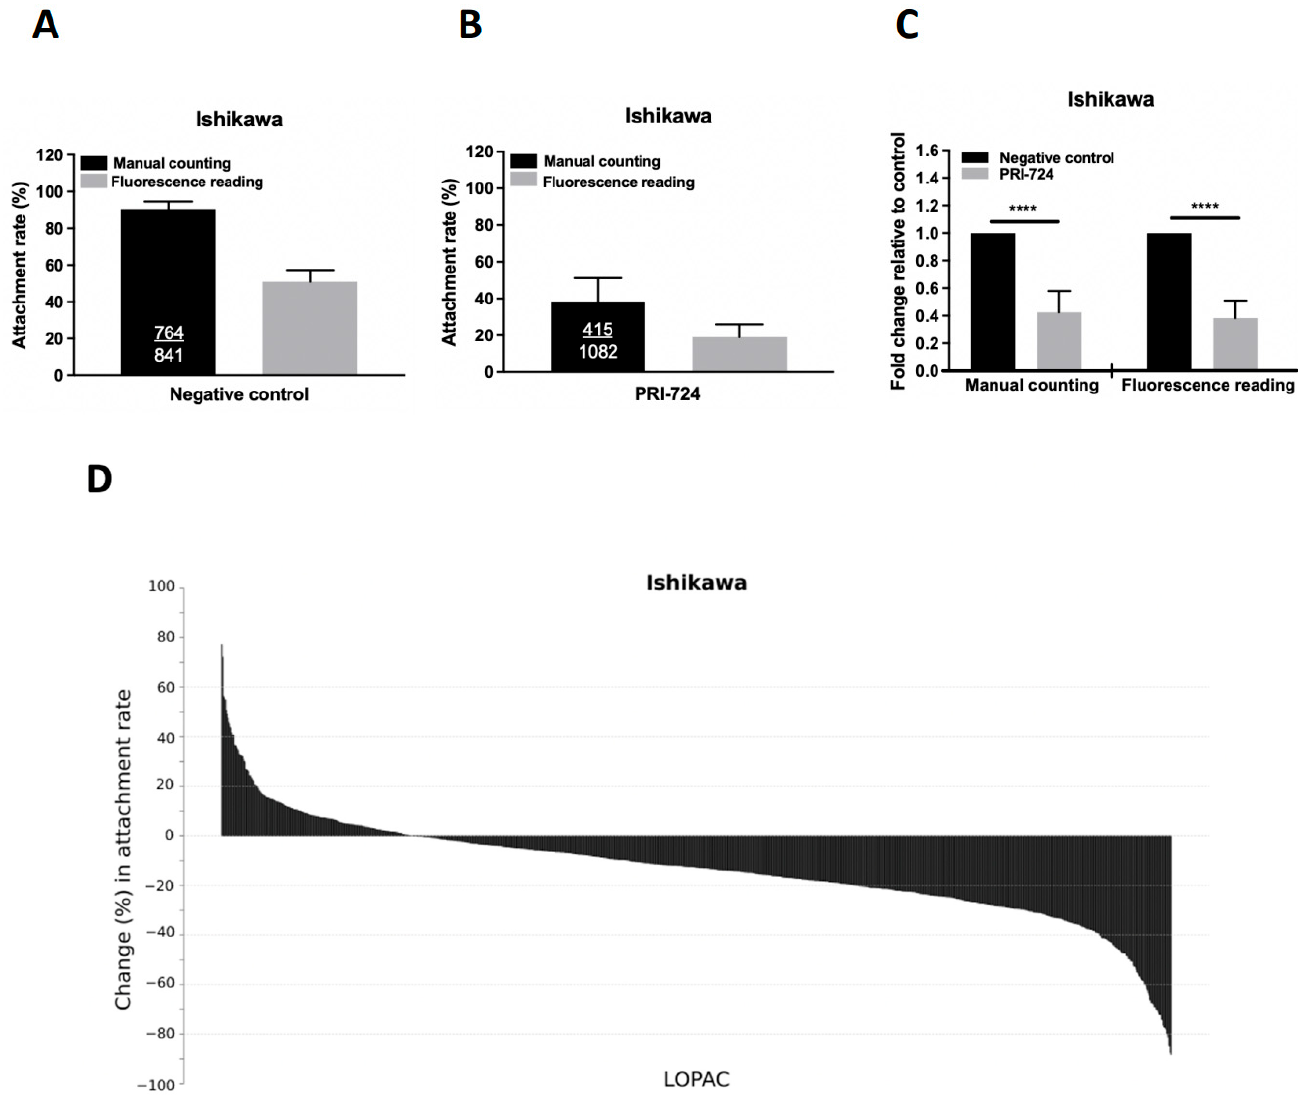
Figure 1. Establishment of the high-throughput attachment assay and primary screening of the LOPAC library. Comparison of the attachment rates of BeWo spheroids onto Ishikawa cells with manual counting (black bar) and fluorescence quantitation (grey bar) in ( A ) negative control, ( B ) positive control with PRI-724, and ( C ) combined results as fold changes in Ishikawa cells with (grey bar) or without (black bar) treatment of PRI-724 by manual counting and fluorescence reading. Ishikawa cells were treated with PRI-724 for 24 h and the number of attached spheroids was manually counted or measured by reading the fluorescence signals. The number of attached spheroids over the number of total spheroids added is shown in the black bars. The attachment rate (percentage) is represented as the mean ± SD and each experiment was repeated three times in triplicate. **** denotes at p < 0.0001 in the Mann–Whitney U test. ( D ) The percentage changes of BeWo spheroid attachment rates on Ishikawa cells treated with 10 µ M LOPAC are presented from the highest to the lowest.